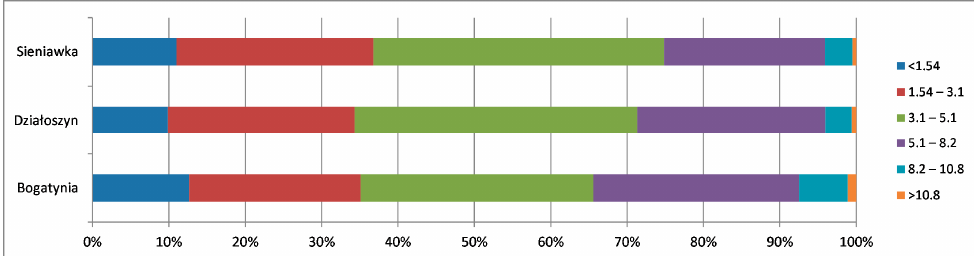
Figure 9. Monthly mean wind speeds determined by the WRF/CALMET model in selected towns in 2018 (source: own study).